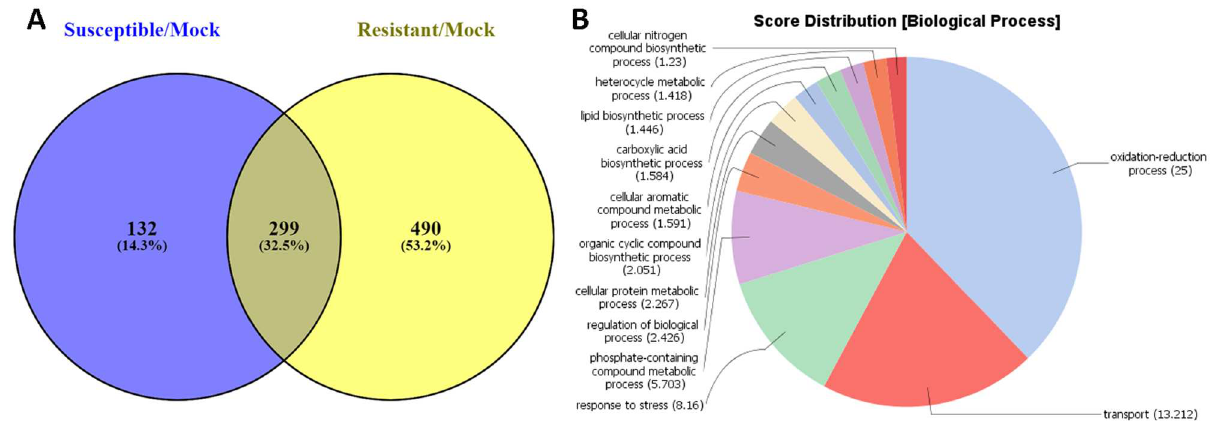
Fig 5. Down-regulated differentially expressedgenes (DEGs) in alfalfa plants from cultivar ZG9830. (A) Venn diagram depictinga number of uniqueand common down-regulated DEGs betweensusceptible and resistant plants 24 hours after inoculation. (B) Functional categorization of the uniquegenesdown-regulated genesin susceptibleplants.